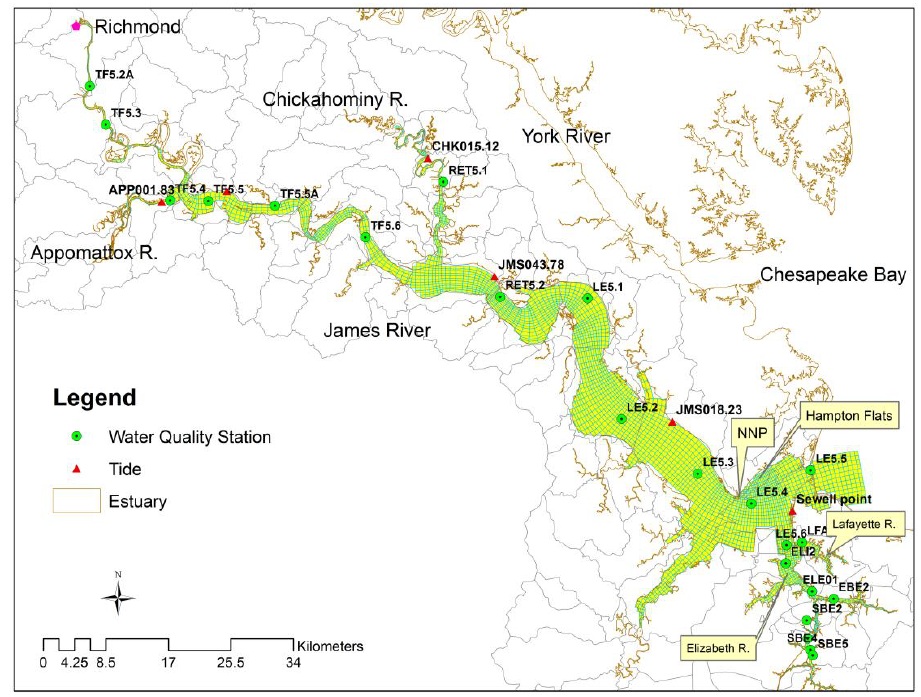
Figure 1. James River model grid and the location of observation stations for tide and water quality. The downstream portion of the James River is distinguished by a meandering main channel. An